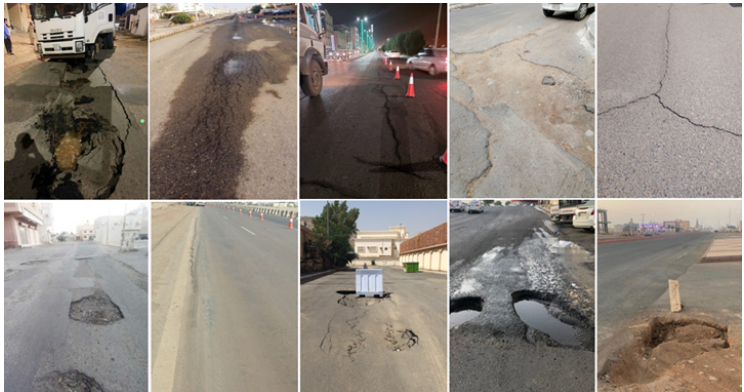
Figure 1. Saudi Arabia Road Damage Dataset Sample.